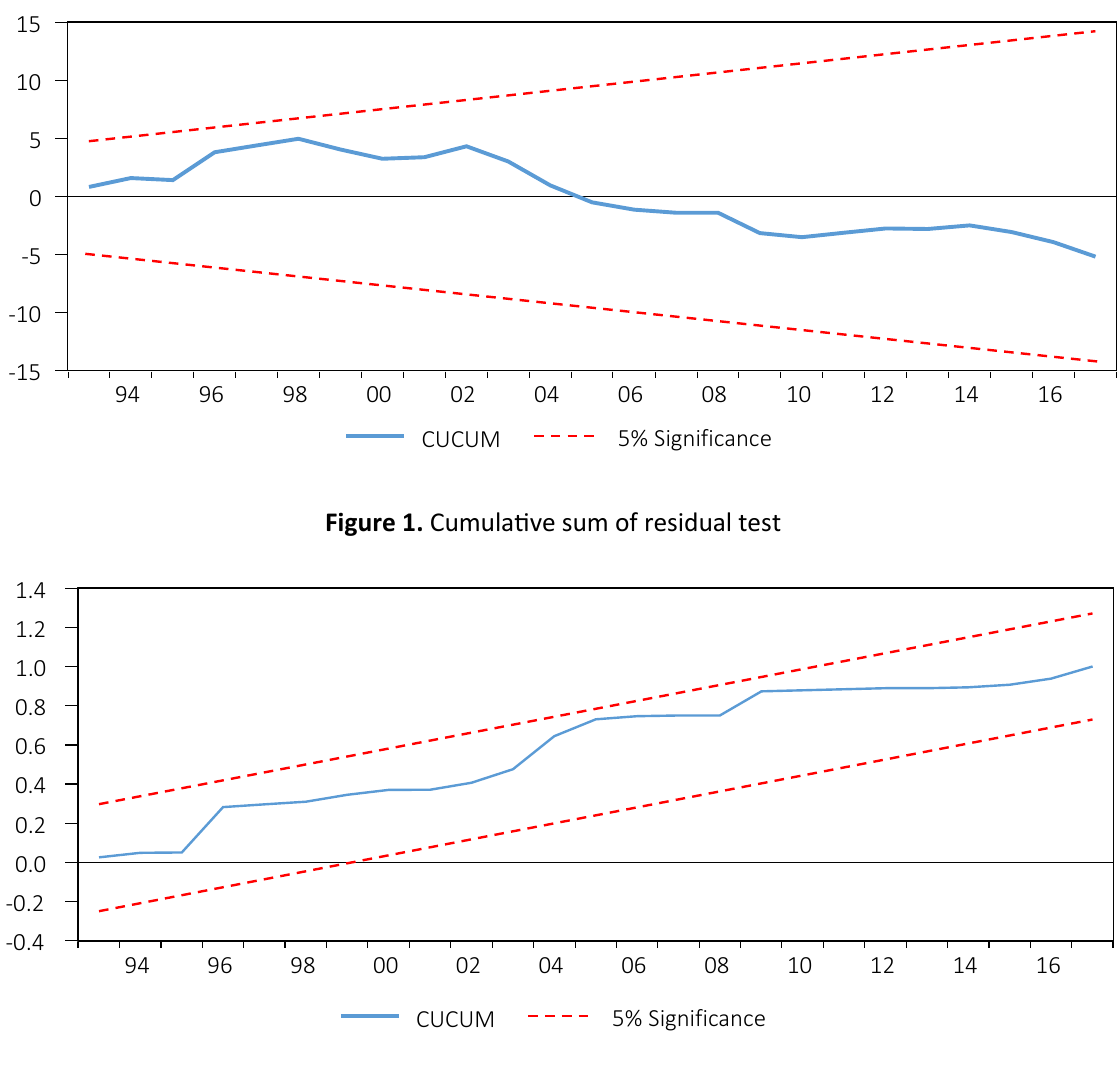
Figure 2. Cumulative sum of squares residual